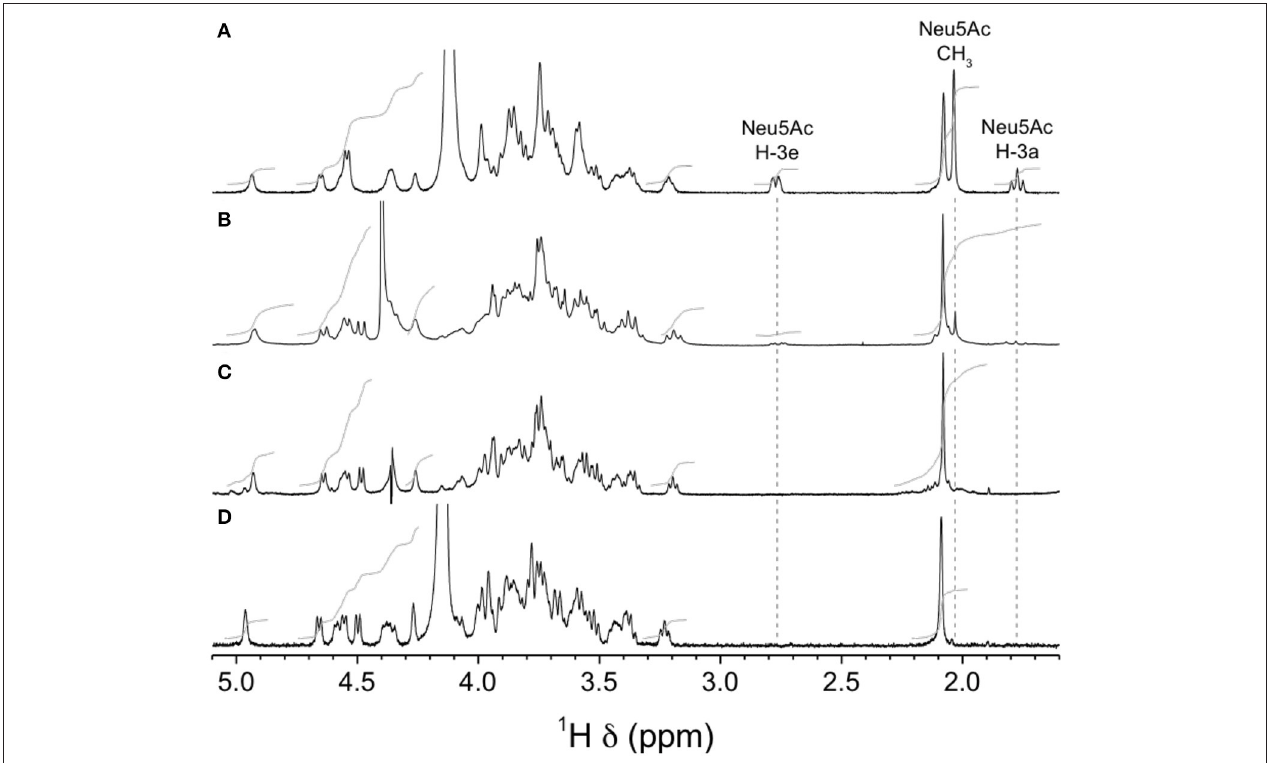
FIGURE 9 | H NMR spectra of native GBS type V and sialic acid-deficient mutant capsular polysaccharides (CPSs). (A) Wild-type, native CPS, D 2 O, 500 MHz, 30 ◦ pulse, 80 ◦ C. (B) GBSV 1 synth ( 1 neu5B ) mutant, native CPS, D 2 O, 300 MHz, 90 ◦ pulse, 60 ◦ C. (C) GBSV 1 siaT ( 1 cps5K ) mutant, native CPS, 33mM phosphate pD 8.0 in D 2 O, 500 MHz, 90 ◦ pulse with presaturation, 67 ◦ C. (D) Wild-type, chemically desialylated polysaccharide, D 2 O, 500 MHz, 30 ◦ pulse, 80 ◦ C.